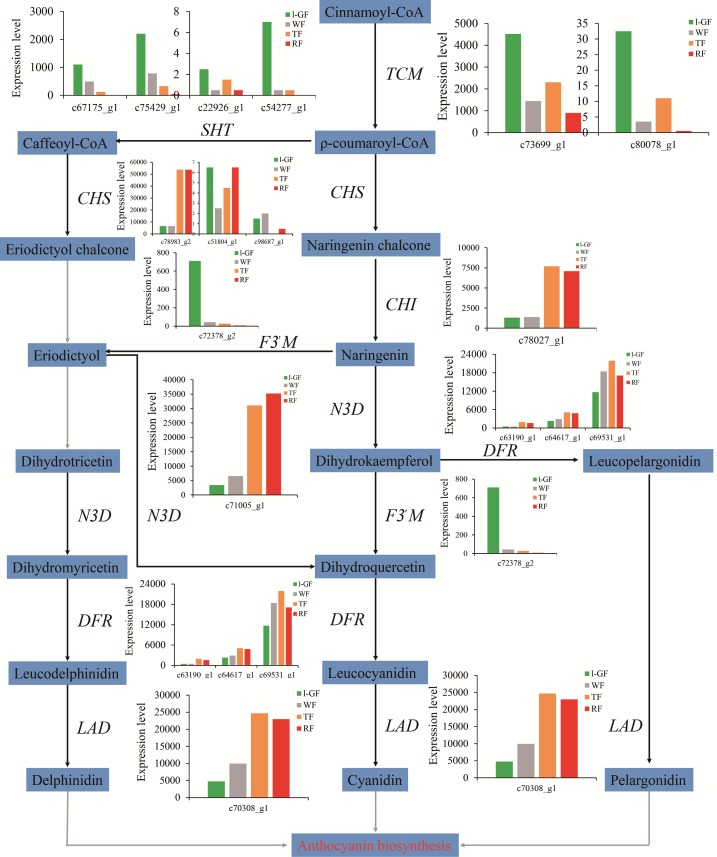
The expression pattern of genes involved in anthocyanin biosynthesis.Enzyme names, unigene ids and expression patterns are indicated on each step. The y-axis represents average read_count value of each library. No gene is found in the grey line step. Study sites: TCM, trans-cinnamate 4-monooxygenase; SHT, shikimate O-hydroxycinnamoyl transferase; CHS, chalcone synthase; CHI, chalcone isomerase; F3′M, flavonoid 3′-monooxygenase; N3D, naringenin 3-dioxygenase; DFR, bifunctional dihydroflavonol-4-reductase; LAD, leucoanthocyanidin dioxygenase; ANS, anthocyanidin reductase.